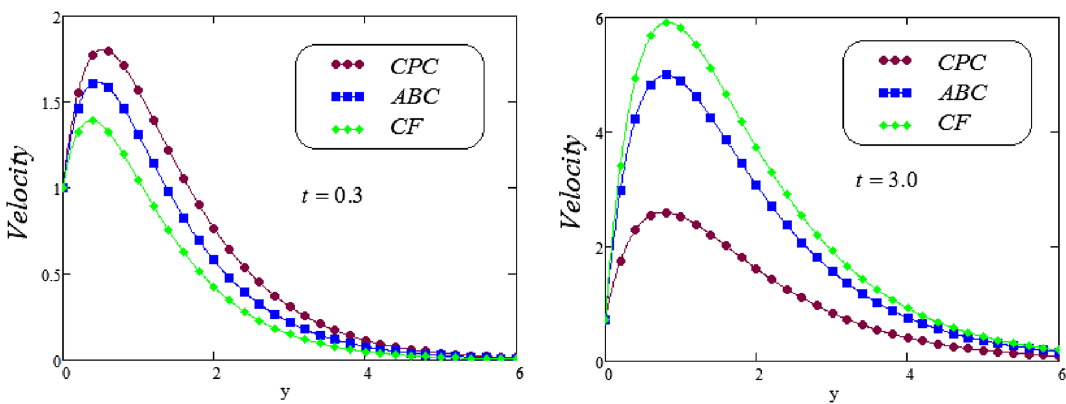
Figure 17. Trace of dimensionless velocity for comparison of CPC, ABC and CF